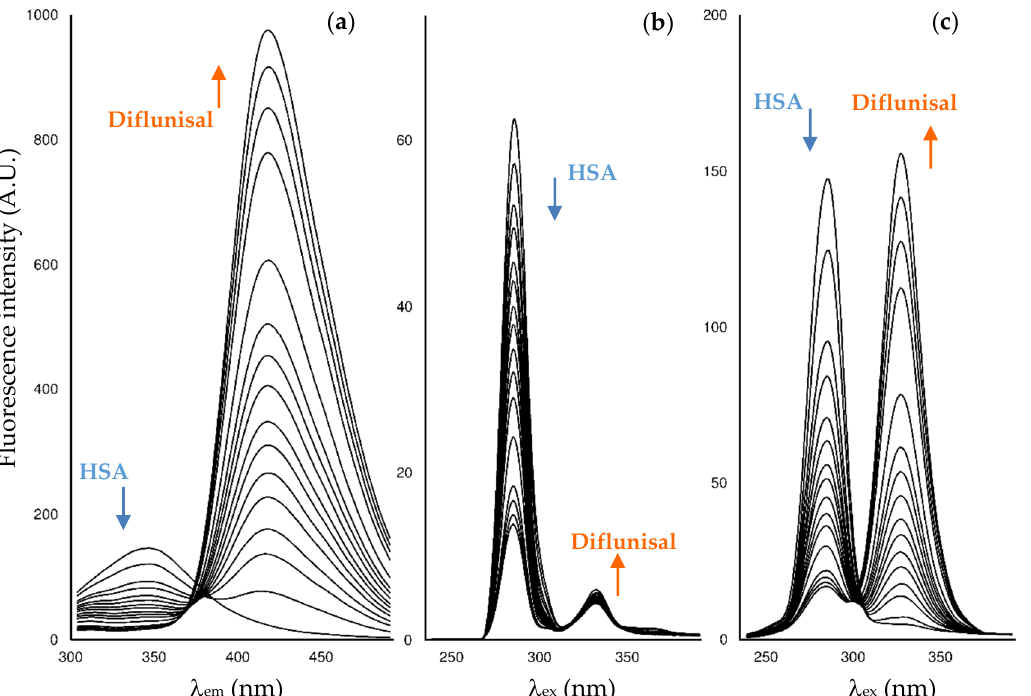
Figure 2. Fluorescence spectrum for diflunisal-HSA at: ( a ) Emission; ( b ) synchronous ∆ λ = 15 nm; ( c ) synchronous ∆ λ = 60 nm modes. The sixteen additions of diflunisal performed to cover the ratio 0.7:13 with respect to the initial concentration of HSA in the cell (4.5 µ